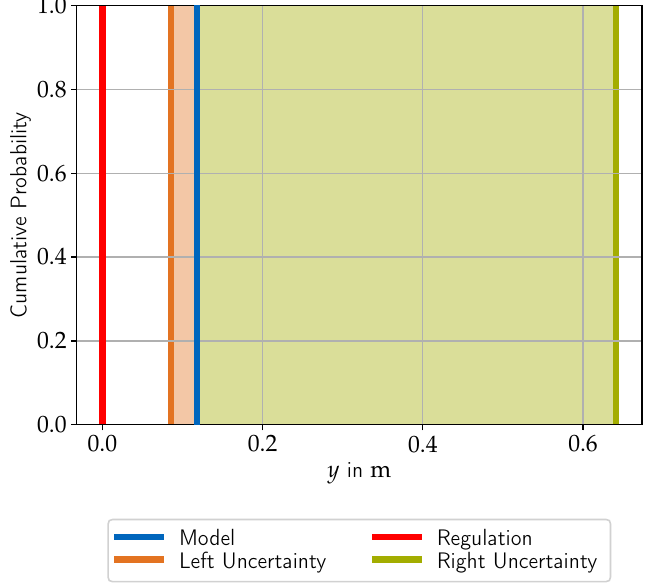
Figure 7. Type approval at the exemplary application scenario v x = 81km/h and a y , ref = 0.35 a y , smax . The shift to the left results from the error model of the left area met- · ric, parameterized over all validation scenarios and inferred to this application scenario, plus its prediction interval. The shift to the right results analogously from the right error model and its prediction